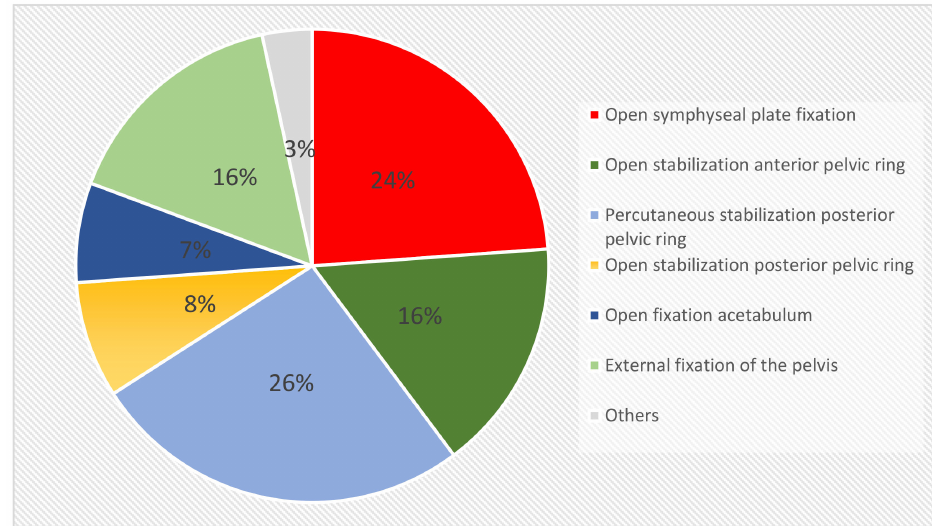
Figure 1. Initial surgical approaches of 43 patients with subsequent implant-associated infections after surgical treatment of fractures of the pelvis and the acetabulum ( n =